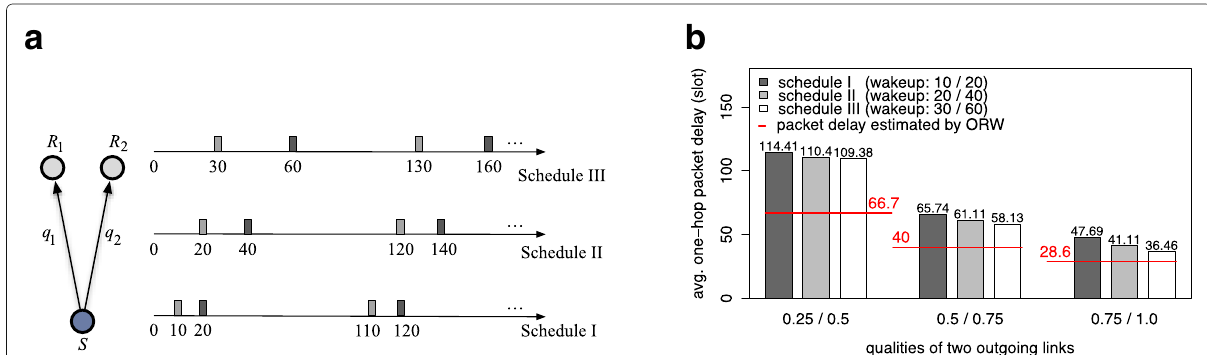
Fig. 1 Effect of sleep schedules on the one-hop packet delay. In simulations, receivers R 1 and R 2 both have a fixed sleep period of 100 slots in their working schedule, and sender S generates around 1000 packets in average. The delay of a packet is the difference from its creation time point to its successful reception time point, including the time for retransmissions. a Three different duty-cycled schedules. b Delay performance under different schedules and link